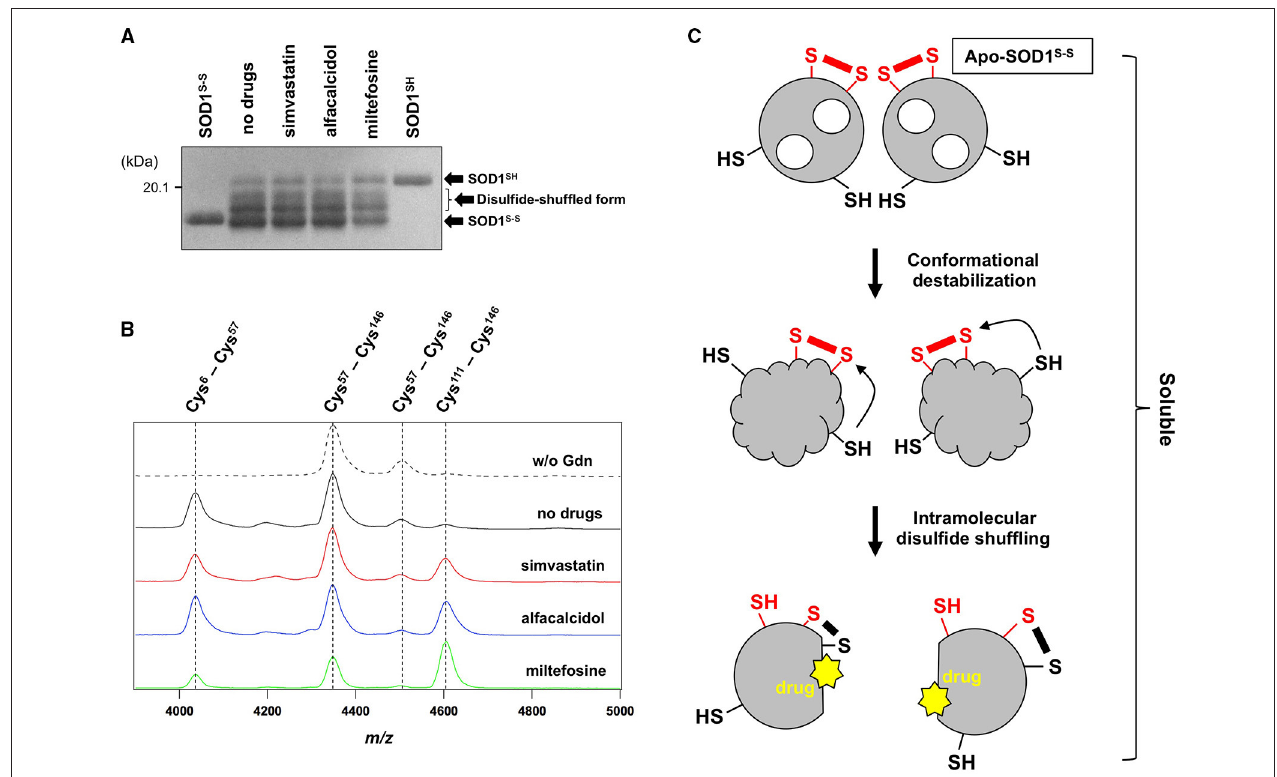
FIGURE 6 | The drugs could not inhibit the disulfide shuffling within an apo-SOD1(G37R) S-S molecule. (A) Apo-SOD1(G37R) S - S (20 µ M) was agitated for 2h in the presence of 1MGdn with and without the indicated drugs, and the soluble fraction obtained with ultracentrifugation was analyzed by non-reducing SDS-PAGE using a 12.5% polyacrylamide gel in the presence of 5M urea. As controls, SOD1 SH and SOD1 S - S were also loaded on a gel. (B) After agitated for 2h at 37 ◦ C in the presence of 1MGdn, the soluble fractions of apo-SOD1(G37R) S - S were trypsinized and analyzed by MALDI-TOF mass spectrometry (see Materials and methods). Reductant-sensitive mass peaks observed at m / z 4038, 4350, 4507, and 4607 were assigned to the peptides containing a disulfide bond between Cys 6 and Cys57, Cys 57 and Cys 146, Cys 57 and Cys 146, and Cys 111 and Cys 146, respectively. (C) Schematic representation of the SOD1 aggregation pathway inhibited by the drugs. Conformational destabilization of apo-SOD1 S - S triggers the intramolecular shuffling of the disulfide bond, and the drugs in this study are considered to interact with the disulfide-shuffled conformation of SOD1 and suppress the interaction of those disulfide-shuffled SOD1 proteins that leads to the formation of insoluble